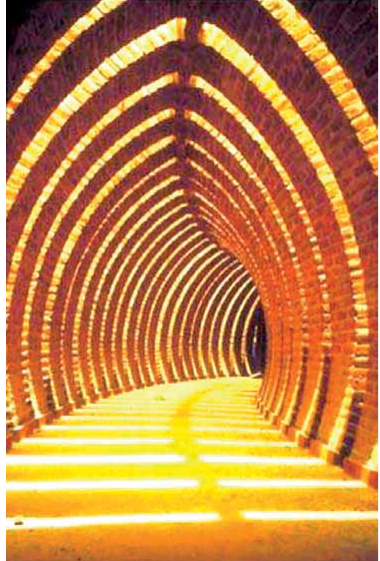
fig. 7. Kaedi Hospital, Mauritania.